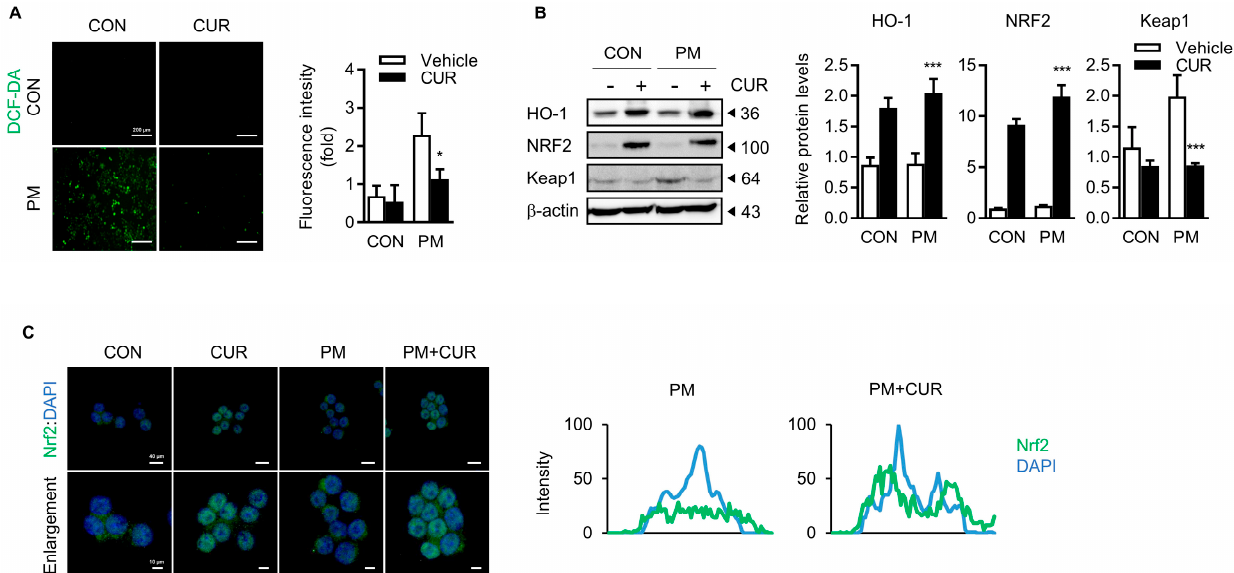
Figure 5. Curcumin reduced the PM-induced oxidative stress through the Nrf2/HO-1 pathway. ( A ) Intracellular ROS measurement. RAW264.7 cells were stained for 30 min using DCFH-DA (10 µ M) after pretreatment of curcumin for 1 h, followed by PM treatment for 24 h. Relative fluorescence intensity was indicated. ( B ) Effect of curcumin on the PM-stimulated oxidative stress pathway-related in RAW 264.7 cells. Immunoblot analysis of Nrf2, HO-1, and Keap1 in RAW264.7 macrophages. β -actin was used as the loading control. ( C ) Effect of curcumin on nuclear translocation of Nrf2 in PM-treated RAW264.7 cells. Confocal imaging shows subcellular distribution of Nrf2. Images show low- ( upper ; scale bars, 40 µ m) and high-power magnification ( lower ; scale bars, 10 µ m). Spatial profiles of fluorescence intensity of Nrf2 along with DAPI, indicating nuclear DNA. Data presented as the mean ± SD of three independent experiments. * p < 0.05, *** p < 0.005 vs. PM-treated group. CON, control group; CUR, curcumin; PM, particulate matter.